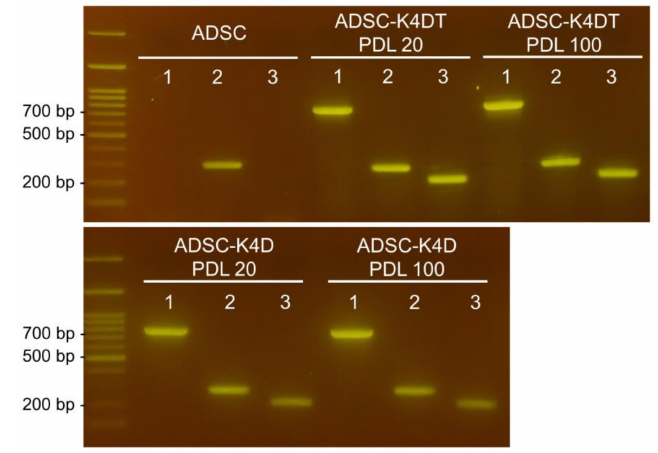
Figure 7. Detection of transduced genes with PCR. Lane 1: canine TERT; Lane 2: canine CCND1; Lane 3: human CDK4R24C.